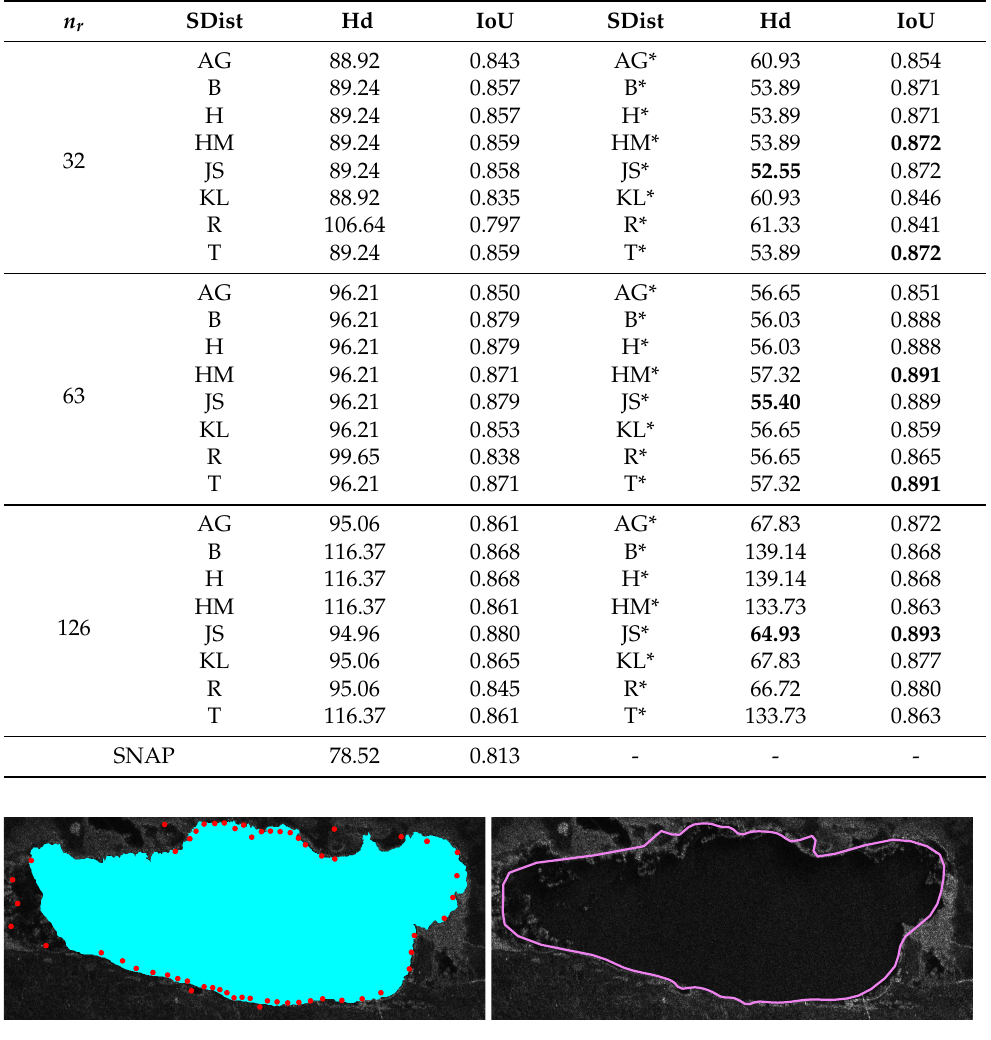
Figure 8. Results of HM* and T* with n r = 63 when the proposed algorithm is applied to the first lagoon in Figure 3